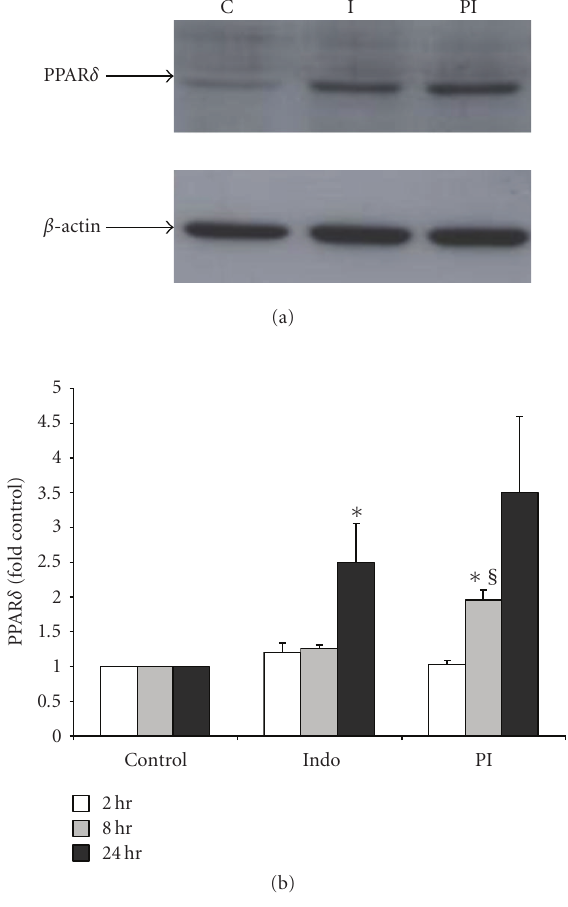
Figure 3: PGE 2 increases PPAR δ protein expression. Protein was isolated from IMCD-K2 cells that had been treated with serum-free media (control, C), 10 − 5 M indomethacin (Indo, I), or 10 − 6 M PGE 2 in the presence of I (PI) 2, 8, and 24 hours. The proteins were (a) run on an SDS-PAGE gel and Western blotted using an anti-PPAR δ antibody (1 : 500). A representative blot of 24-hour treatment is shown. The membranes were stripped and β -actin was detected to normalize samples for (b) densitometric analysis. Expression is presented as fold of control. Values are means ± S.E.M.; n = 3–6. ∗ P < . 05 compared to control; § P < . 05 compared to indomethacin.